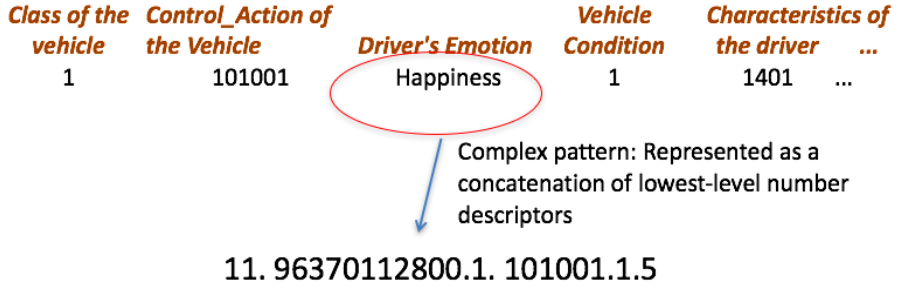
Figure 5. Ar2p model for the State Layer.